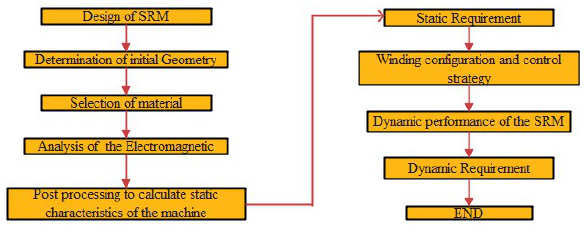
Fig. 2. SRM design flow